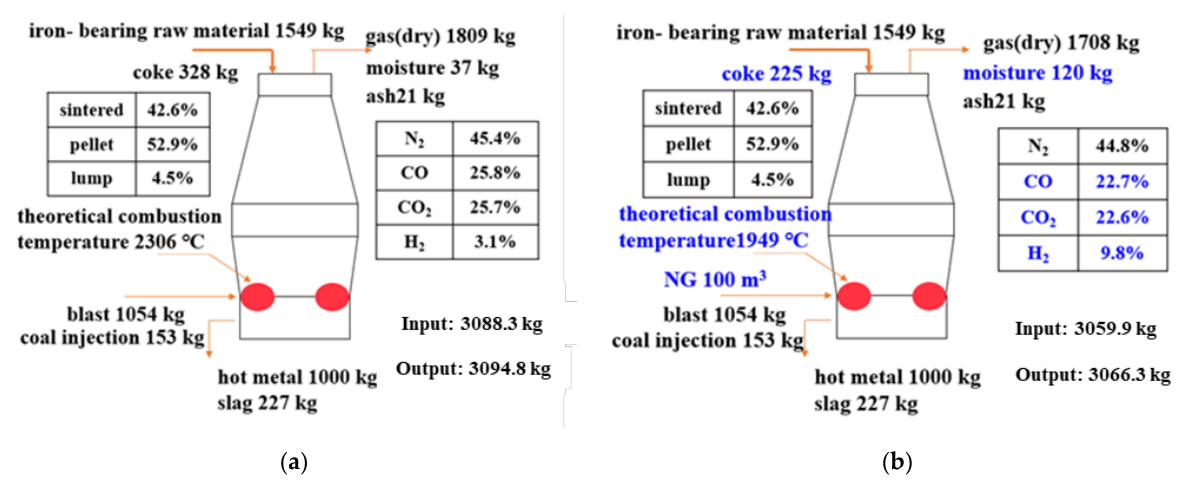
Figure 1. Comparison of mass flow for base case ( a ), and injection of 100 m 3 /t NG without thermal compensation ( b ).